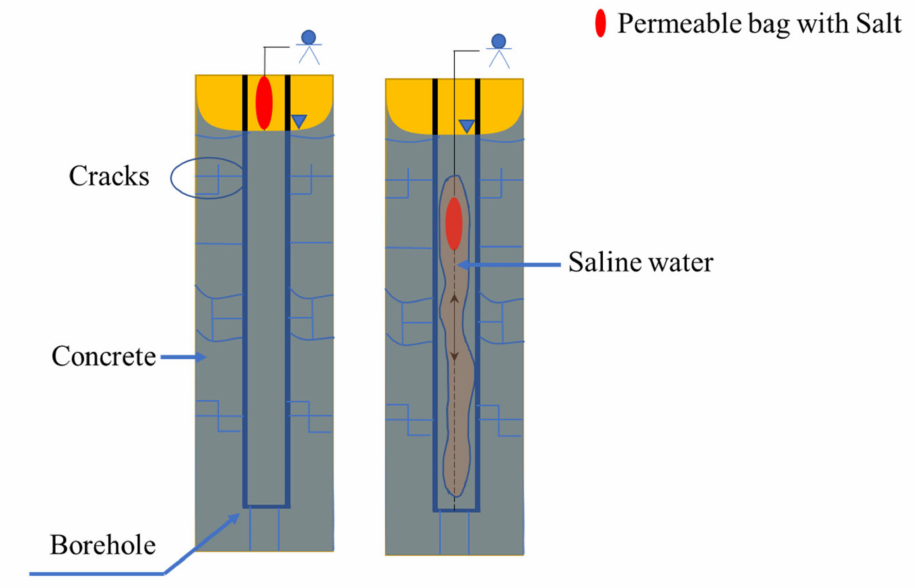
Figure 5. Illustration of injections with permeable bag containing